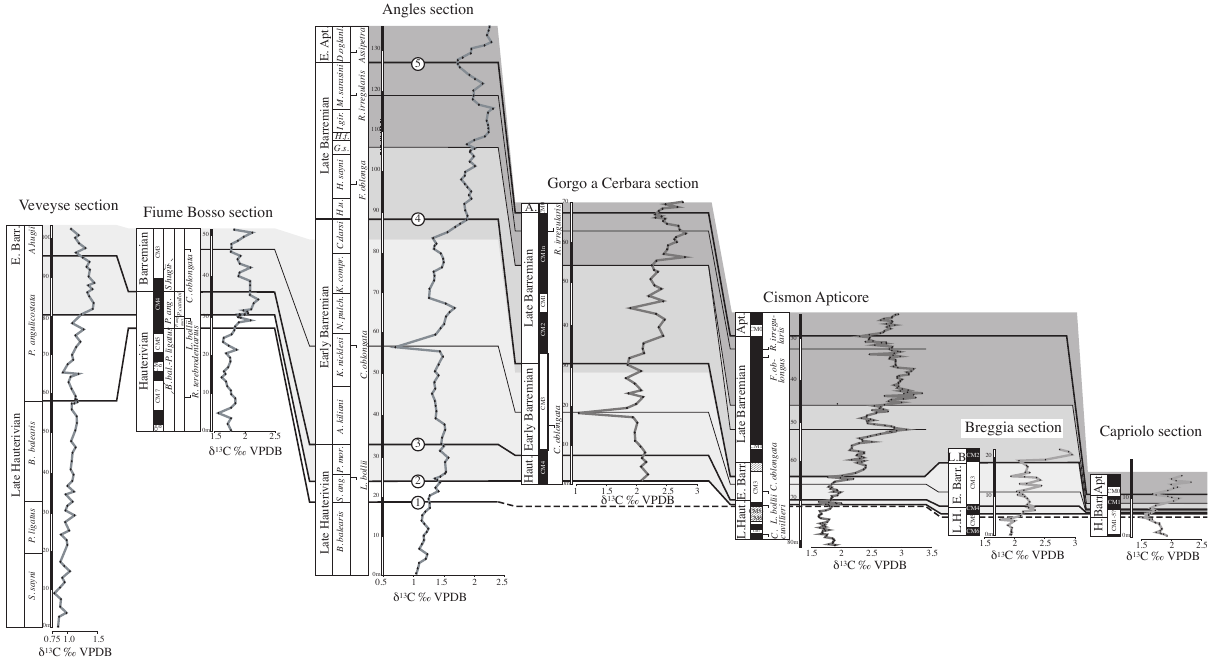
Fig. 9. Correlation of the δ 13 C records of the Veveyse de Chˆatel Saint Denis, Fiume Bosso, Angles, Gorgo a Cerbara and Cismon Apticore Föllmi et al., Fig. 9 sections and cores (modified from Godet et al., 2006) and the Breggia and Capriolo records.